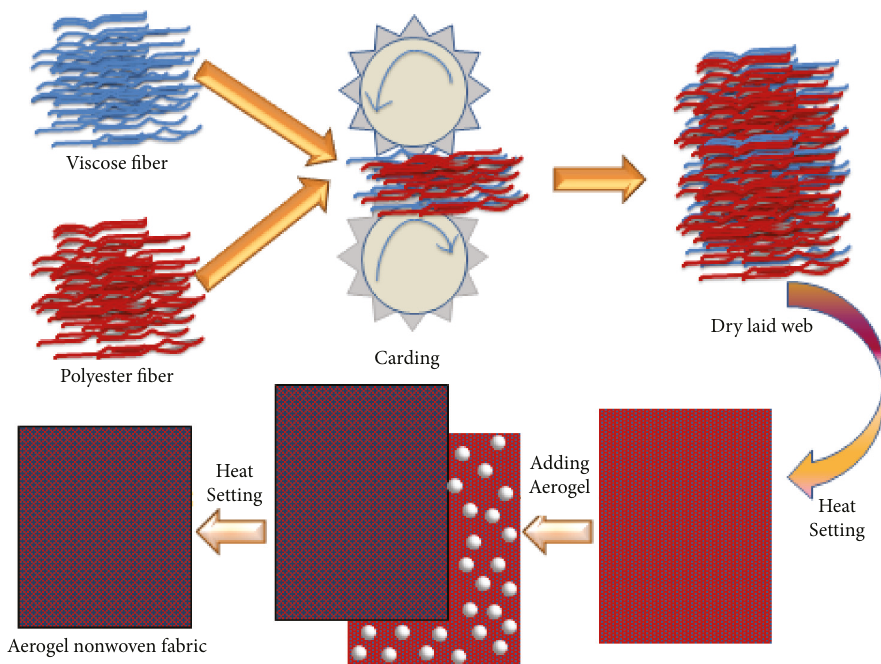
Figure 11: Schematic diagram for the development of aerogel nonwoven